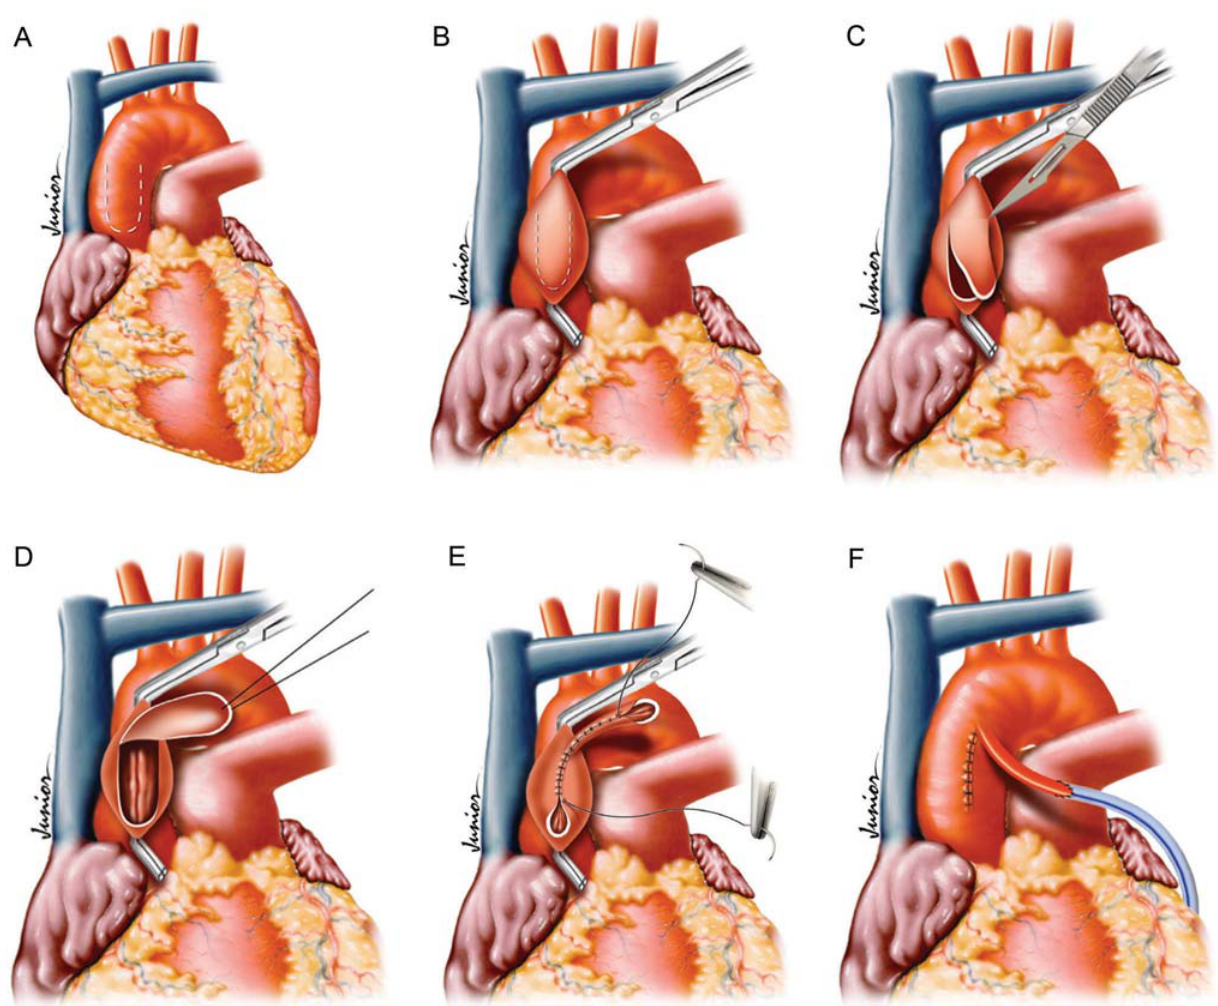
Figure 1 (A-F) - Schematic representation of surgical